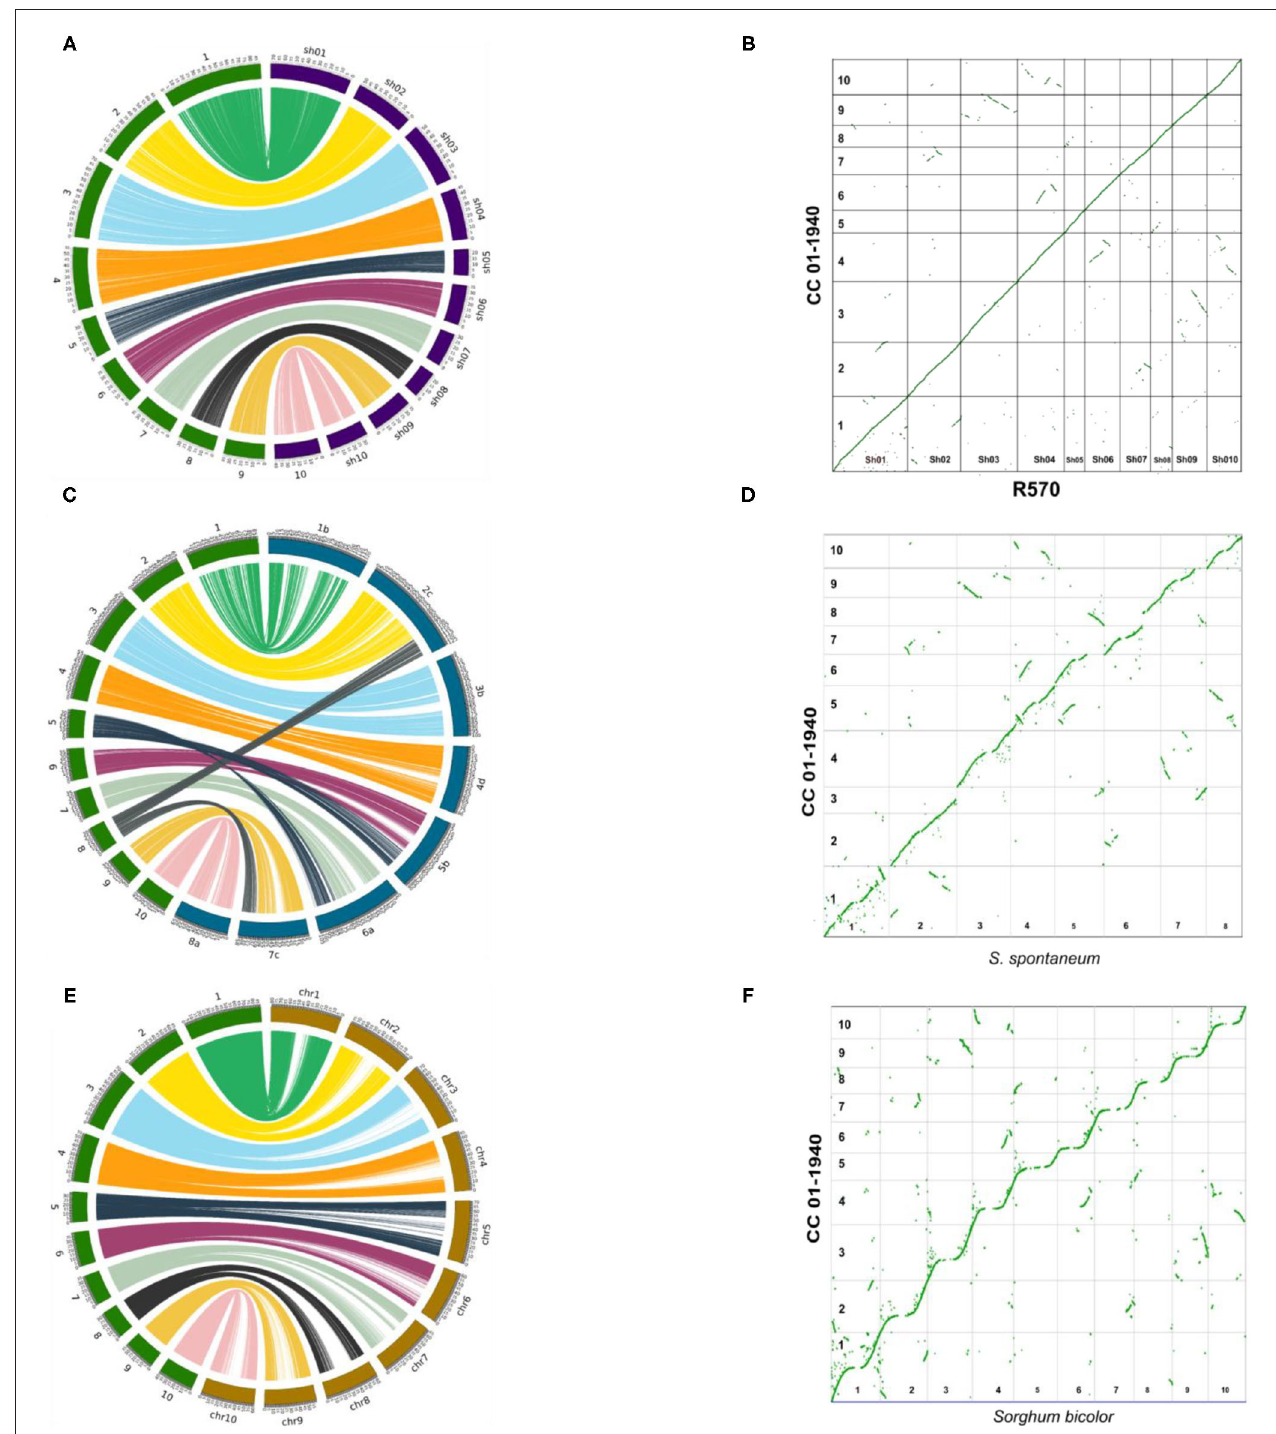
FIGURE 2 | Circus and dot plot graphs showing the collinearity/synteny between the genome of CC 01-1940, and R570 (sugarcane hybrids), S. spontaneum and sorghum bi-color. In each left graph, CC 01-1940 chromosomes are represented in green, the R570 chromosomes in purple, S. spontaneum in blue and Sorghum in brown. On the right side, the insertions and translocation between the same genomes are represented using a dot plot graph. (A) Collinearity between CC 01-1940 and R570. (B) Synteny dot plot between 01-1940 vs. R570. (C) Collinearity between CC 01-1940 and S. spontaneum. (D) Synteny dot plot between 01-1940 vs. S. spontaneum . (E) Collinearity between CC 01-1940 and Sorghum. (F) Synteny dot plot between 01-1940 vs. Sorghum.